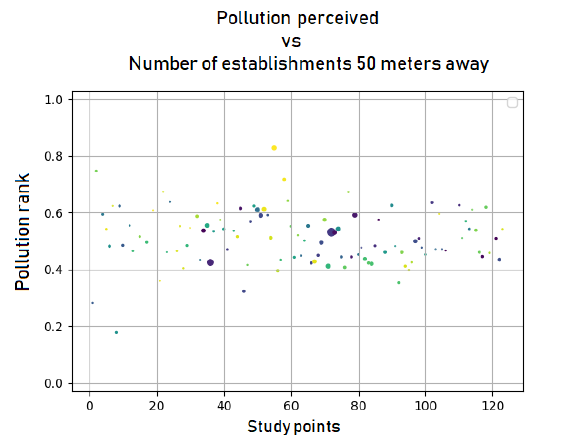
Figure 12. Relation between Pollution VS Number of establishments nearby. It can be seen that the higher perception of Pollution the greater Number of establishments